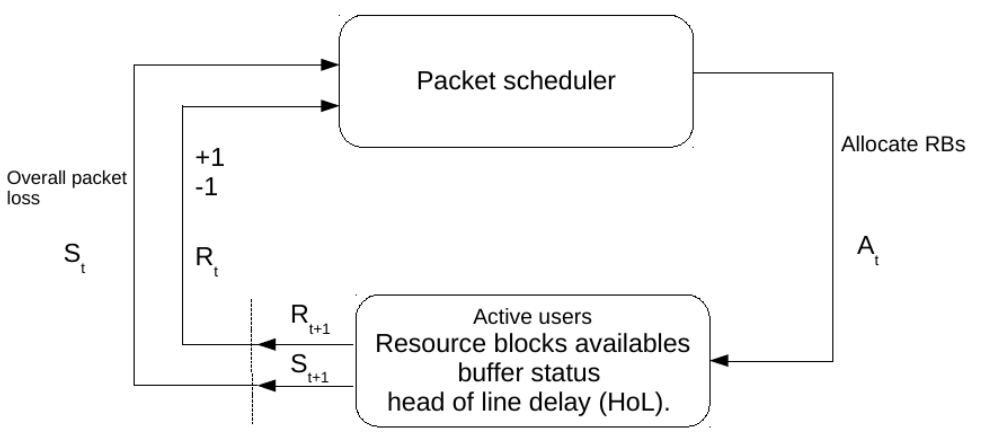
Figure 2. Reinforcement learning agent–environment interaction for resource